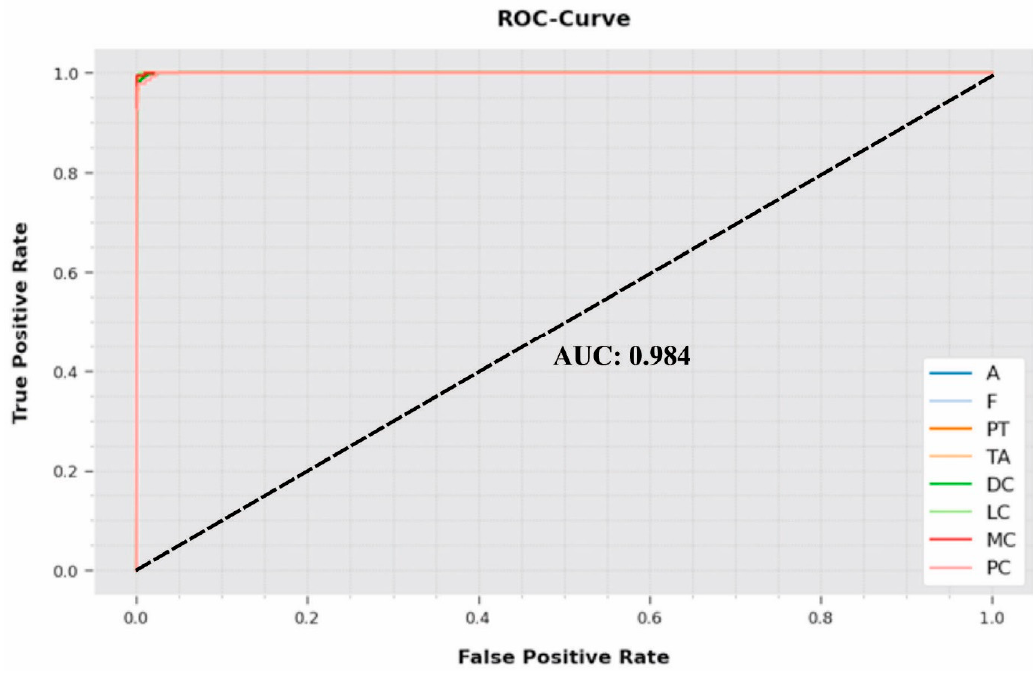
Figure 9. ROC curve analysis results of the IBESSDL-BCHI approach.